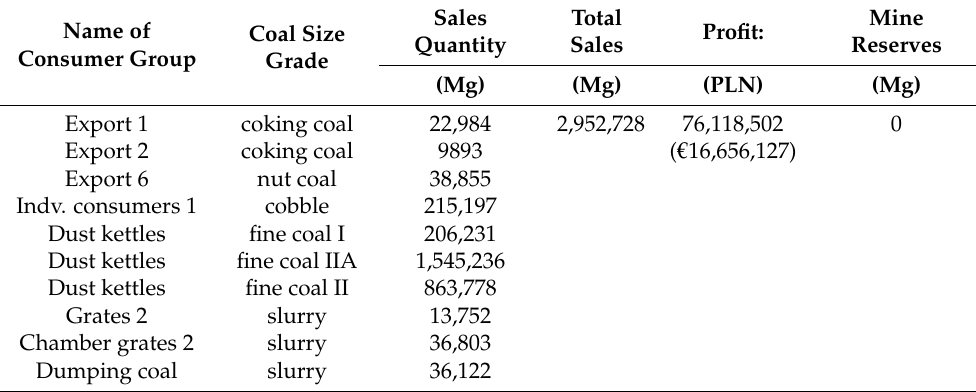
Table A8. The optimal production and sales plan for mine “E” for 2021.